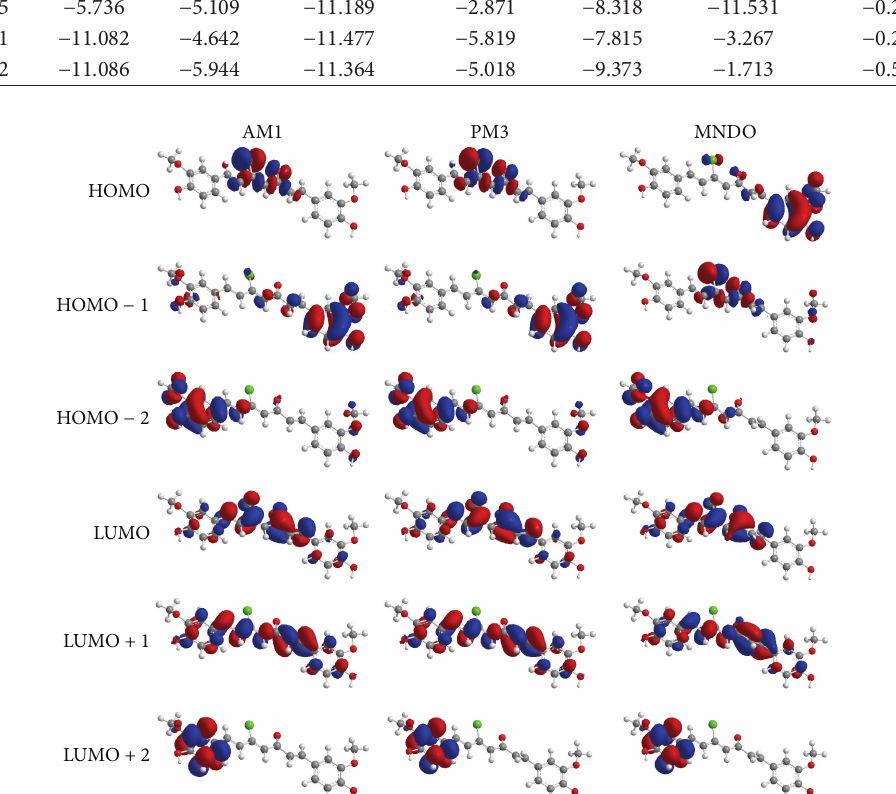
Figure 3: The highest occupied molecular orbital (HOMO) and the lowest unoccupied molecular orbital (LUMO) of 5-chlorocurcumin.